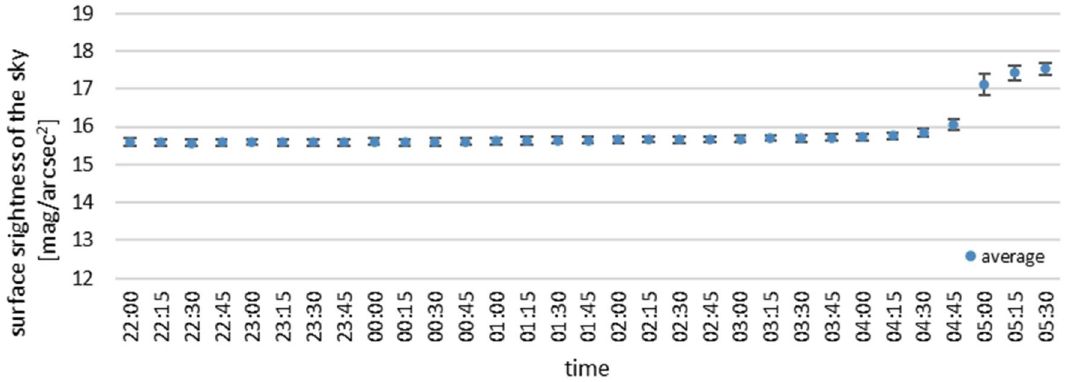
Figure 10. Summary of measurements from all devices during completely cloudy night of November 31 to December 1, 2020.